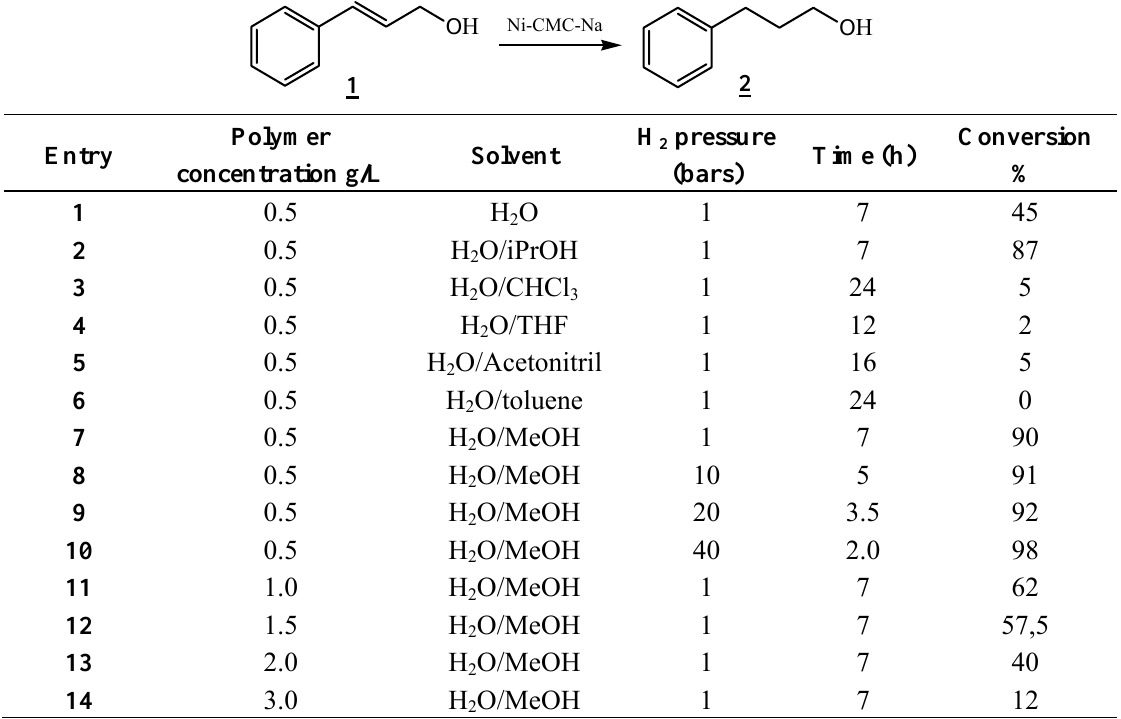
Table 1. Hydrogenation of cinnamyl alcohol ( 1 ) catalyzed by Ni(0)-CMC-Na colloids: Influence of nature of solvent, concentration of polymer and hydrogen pressure. O H